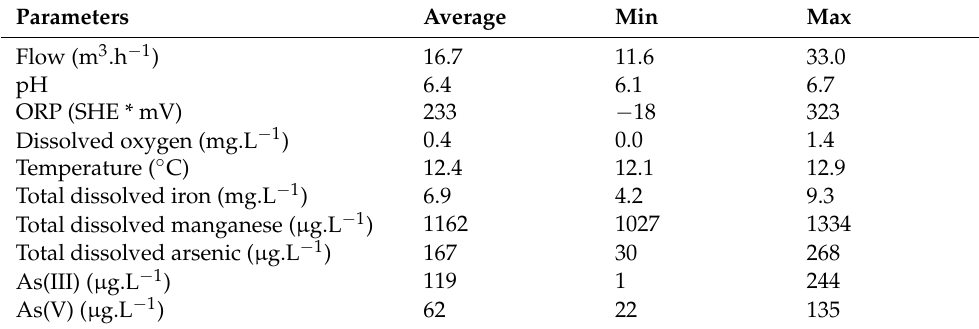
Table 1. Lop é rec mine drainage characteristics during the monitored period, from April to August 2017 and from March to July